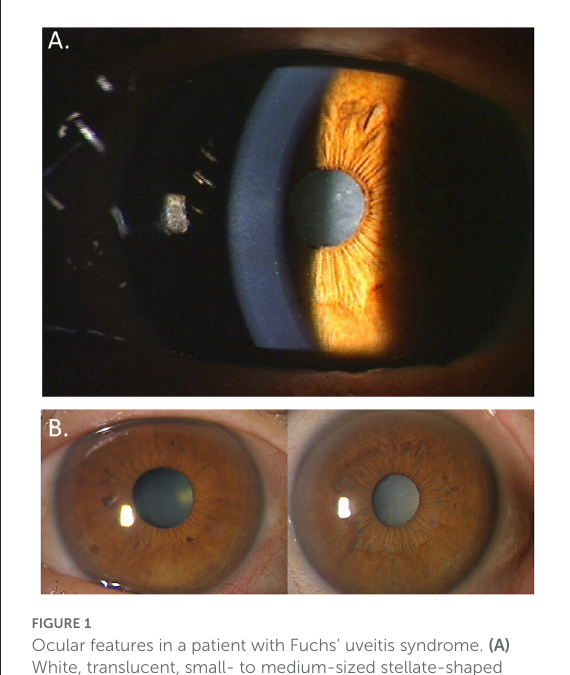
FIGURE1 Ocular features in a patient with Fuchs’ uveitis syndrome. (A) White, translucent, small- to medium-sized stellate-shaped keratic precipitates are observed. (B) Diffuse iris stromal atrophy and cataract are seen in the left eye compared to the normal right eye.